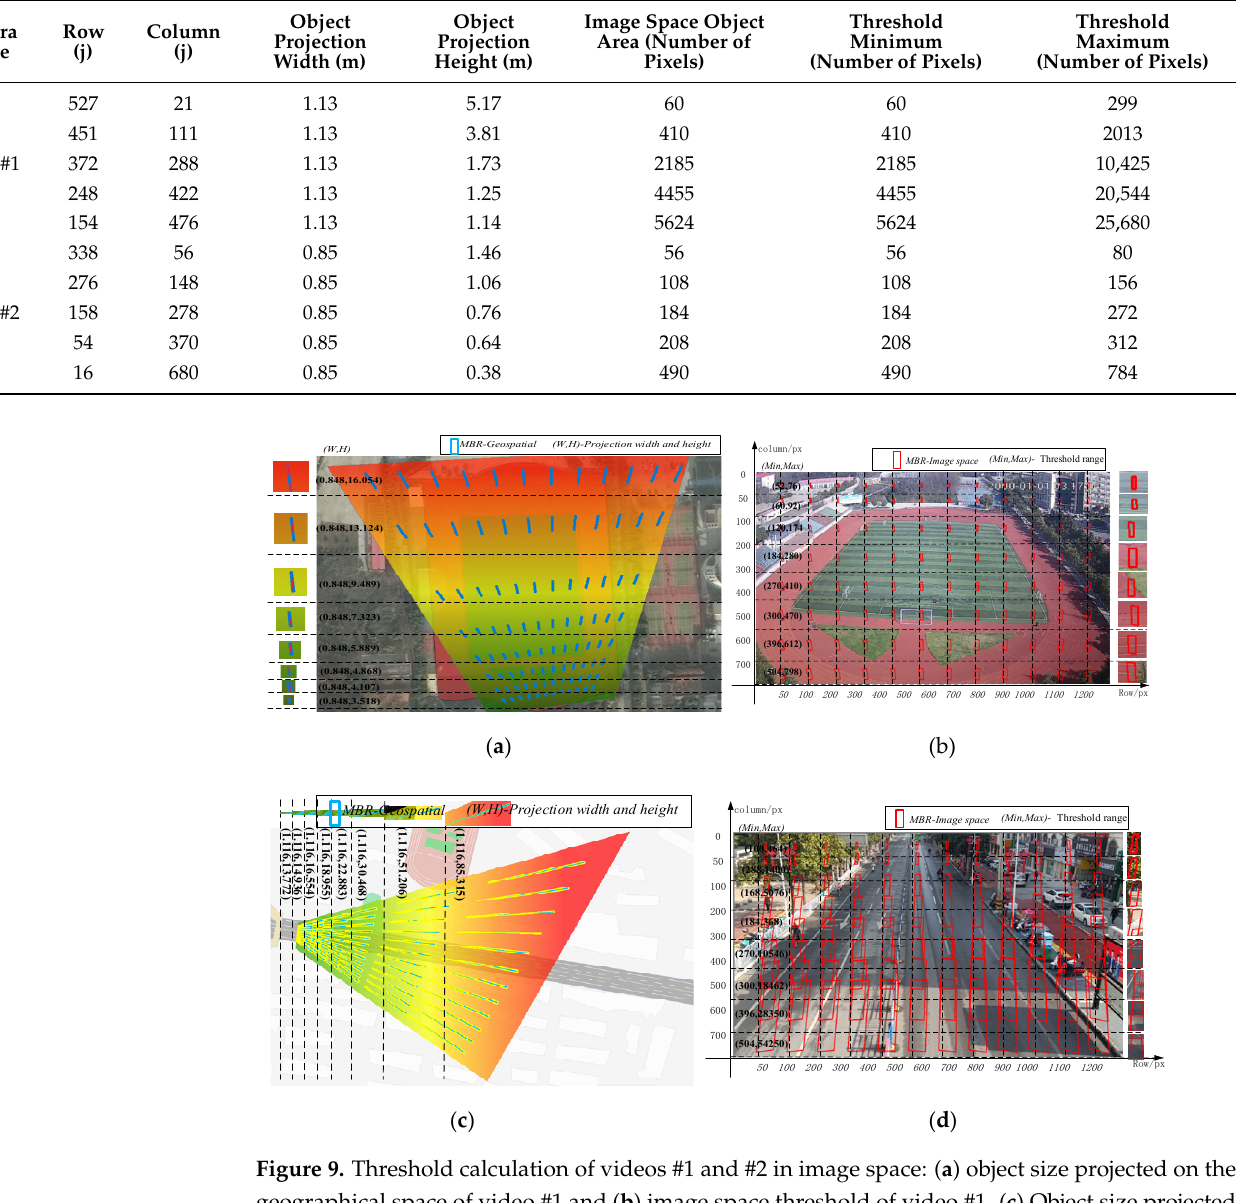
Figure 8. Maximum threshold range of videos #1 and #2: Object location and threshold range of ( a ) video #1 and ( b ) video #2. ( c ) Statistics of the width and height in video #1 are 1.0–2.0 times the threshold range and object-size change, respectively. ( d ) Statistics of the width and height in video Table 2. Threshold information of videos #1 and #2. #2 are 1.0–2.0 times the threshold range and the object-size change, respectively.